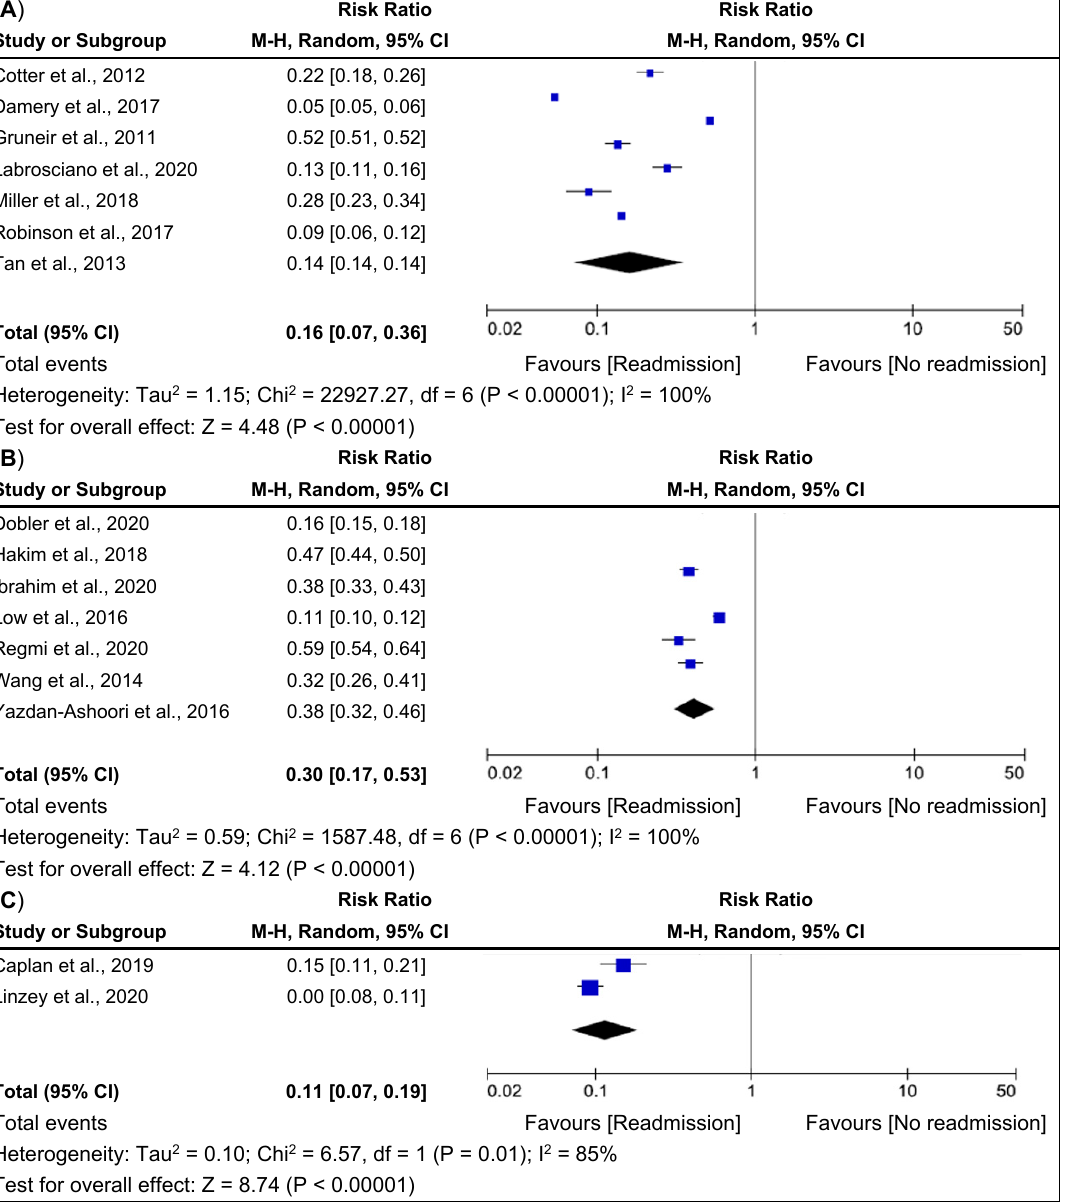
Figure 3. Forest plot of LACE Risk Ratio for 30-day hospital admissions with LACE index in by different disease conditions based on the selected studies. ( A ). All cause readmissions [10,15,16, 19,22,30,31], ( B ), Cardiovascular and Pulmonary conditions [11,13,17,18,20,21,29]; ( C ) Neurological conditions [12,14]. Boxes indicate risk ratios (RRs); whiskers, 95% CIs; diamonds, pooled RR of readmission; vertical straight lines, overall pooled RR at 1.00 level. M-H = Man-tel-Haenszel; CI = confidence